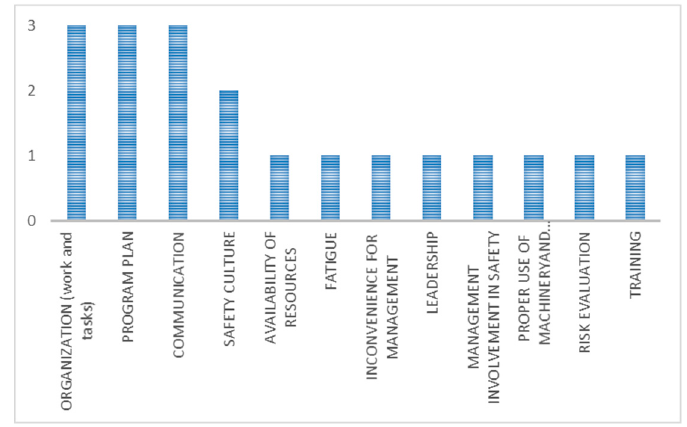
Figure 10. Main contextual factors (in terms of number of occurrences) in techno-organizational interventions with expected outcome.